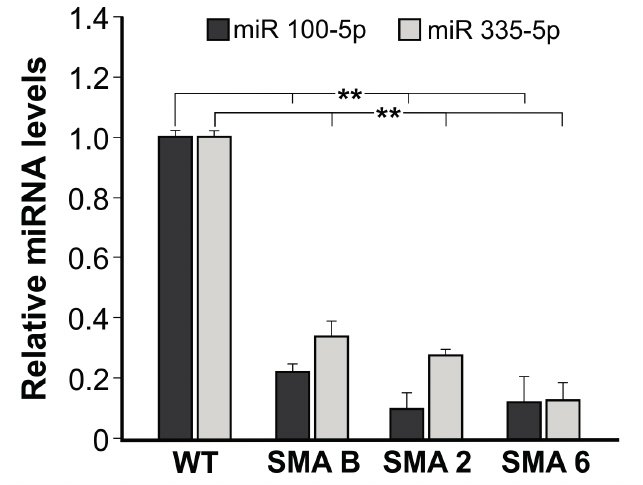
Figure 3. Real-time RT-PCR analyses of miR-100-5p and miR-335-5p. Real-time qPCR of miR-100-5p and miR-335-5p in three distinct NSCs SMA samples (SMA B, SMA 2, SMA 6) derived from spinal cord, using WT sample as references. The data were normalized to internal control small nucleolar RNA234 (snoRNA234). Data are representative of three independent biological replicates; values represent mean ± SD; ** p =